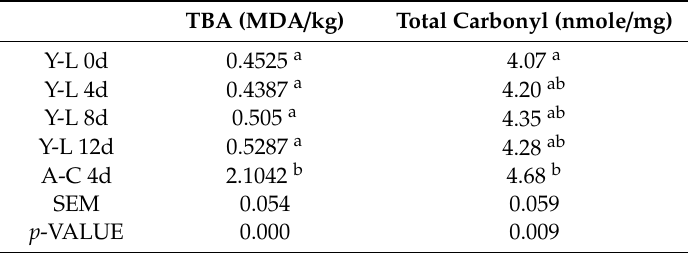
Table 1. Lipid and protein oxidation quantification of Young-Linseed (Y-L) and Adult Conventional (A-C) foal meat. TBA (MDA /